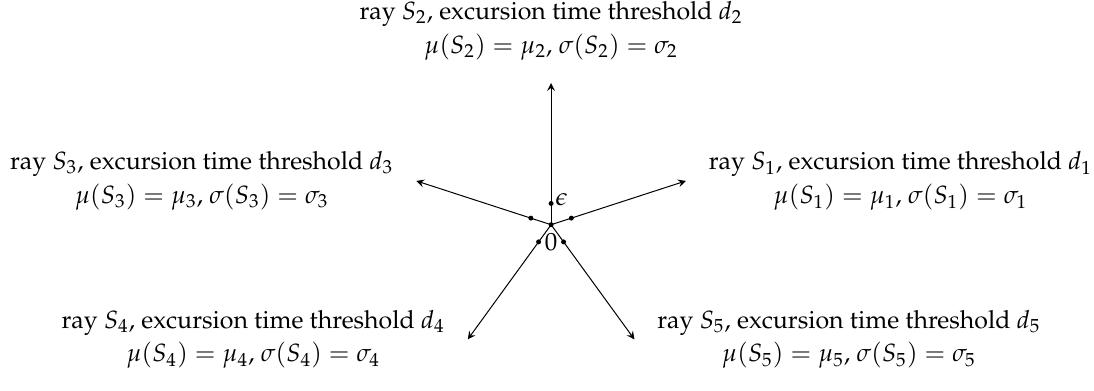
Figure 1. A system of 5 rays emanating from a common